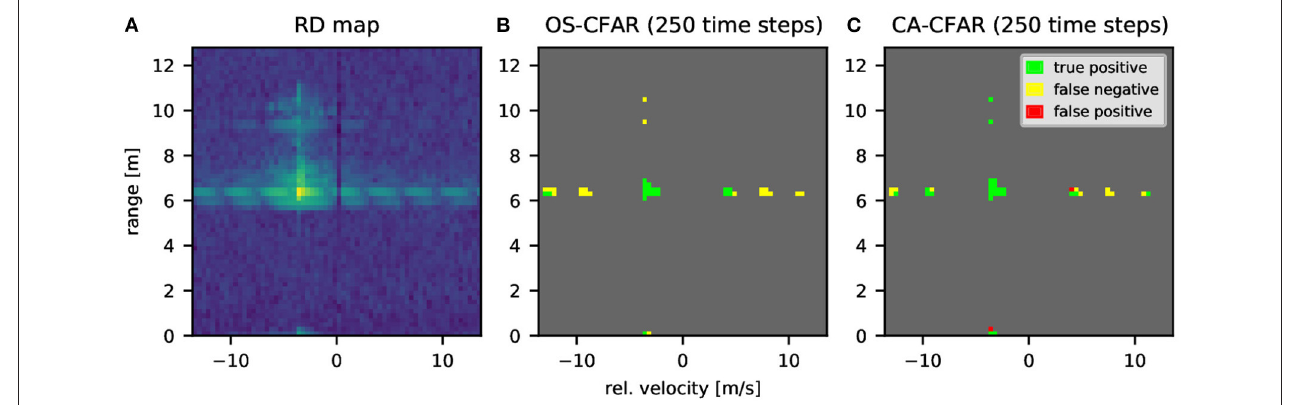
FIGURE 6 | Example of object detection with spiking CFAR algorithms. (A) Exemplary range-Doppler map from CARRADA dataset. (B,C) Results of spiking OS-CFAR (B) and spiking CA-CFAR (C) applied to the range-Doppler map from A and comparison to original algorithms. Green points mark reflections detected by both classical and spiking algorithm. Yellow points are detections missed by the spiking version (false negatives) and red points are false positive detections by the spiking algorithm. The SNNs were simulated with 250 time